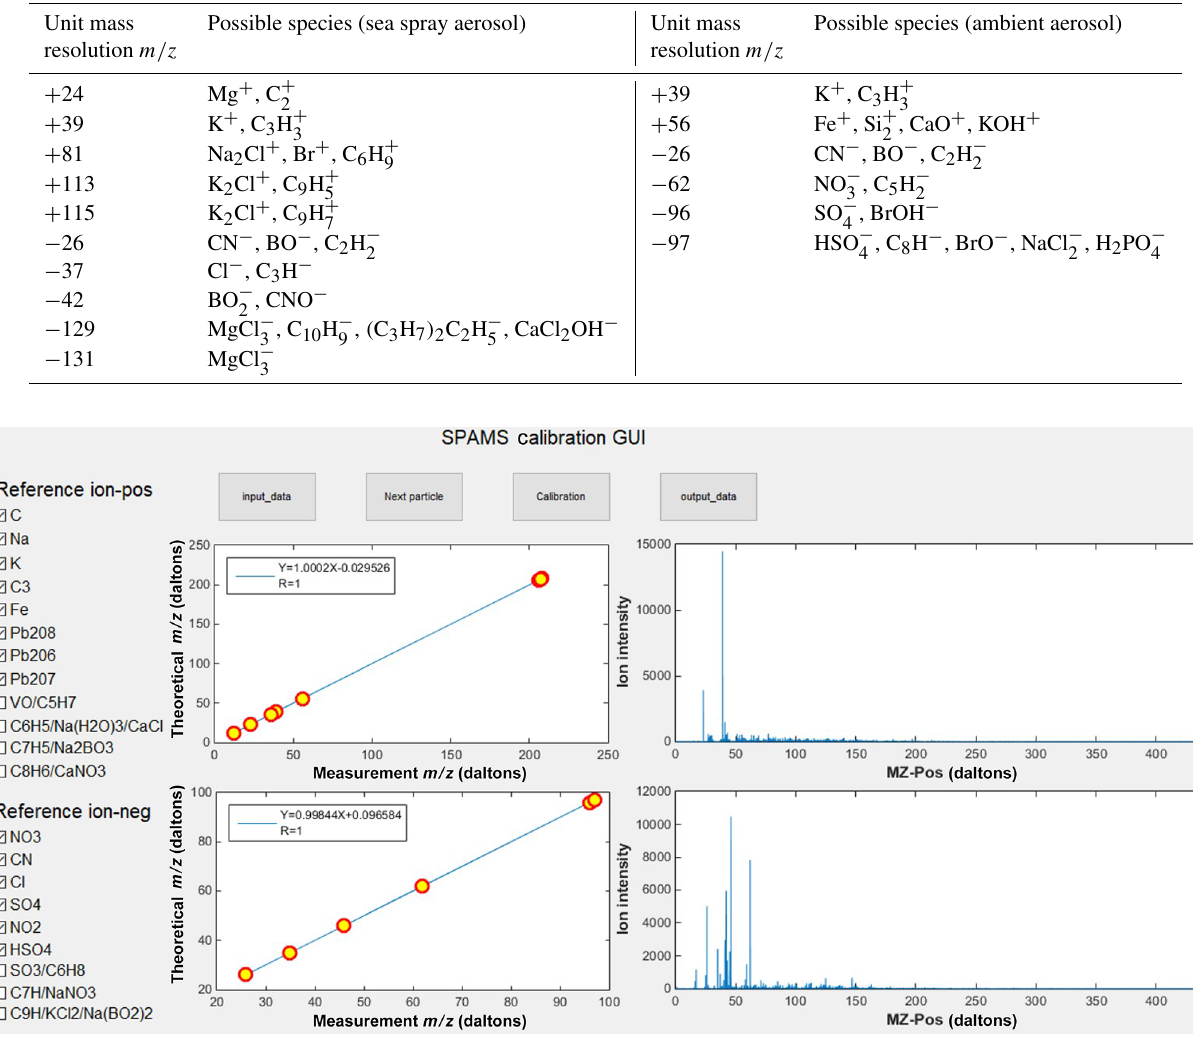
Figure 1. The GUI program for HR-SPAMS calibration.